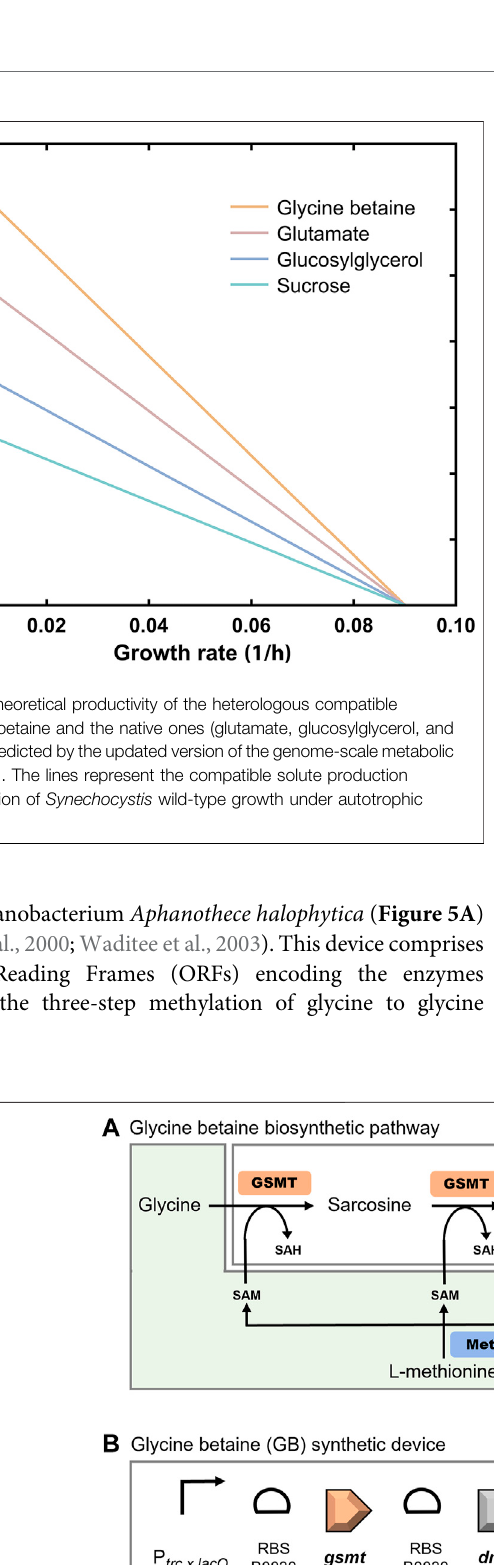
Frontiers in Bioengineering and Biotechnology |